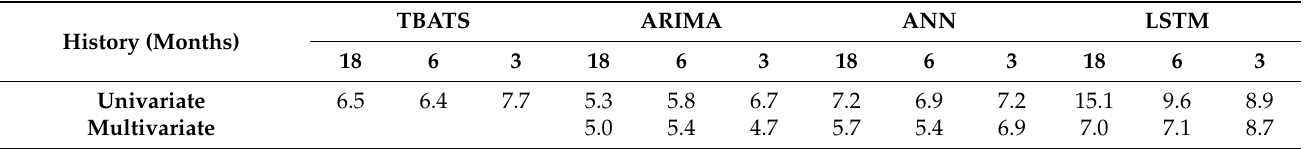
Table 5. Accuracy of one-step-ahead forecasting at the national scale.